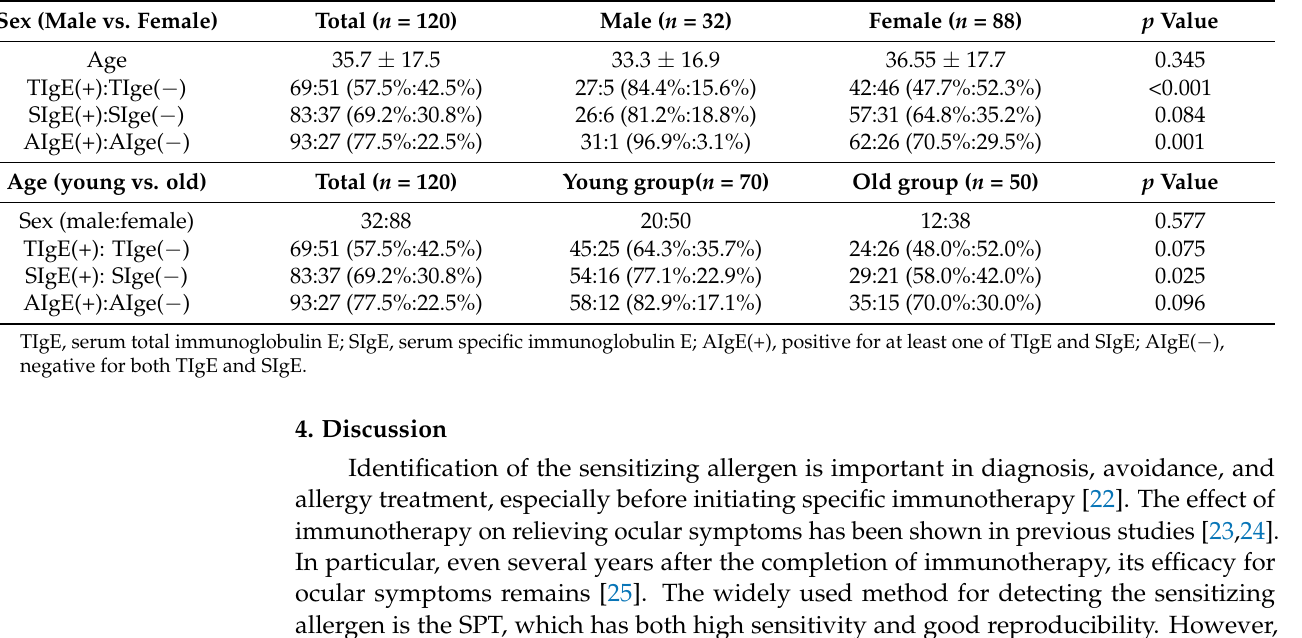
Table 3. Comparison of the test results between sex and age